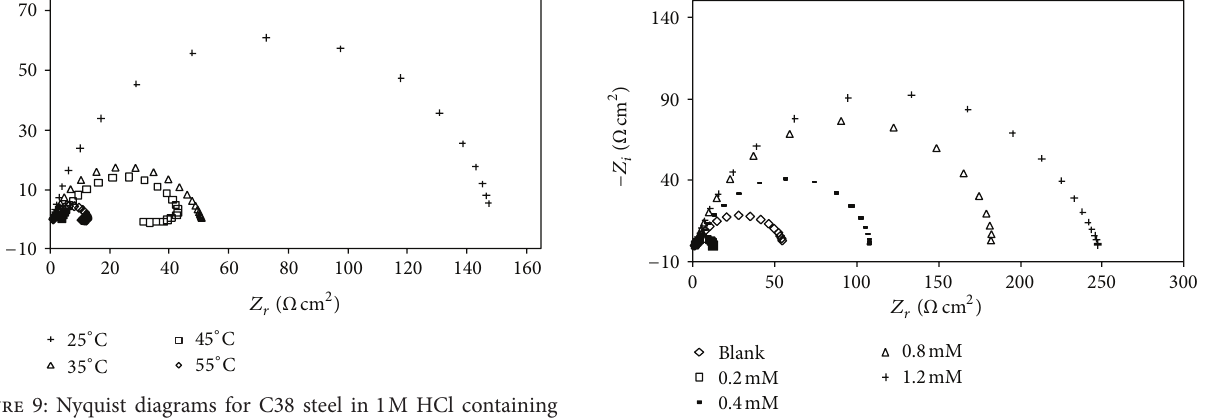
Figure 11: Nyquist diagrams for C38 steel in 1M HCl containing different concentrations of noharmane at 35 ∘